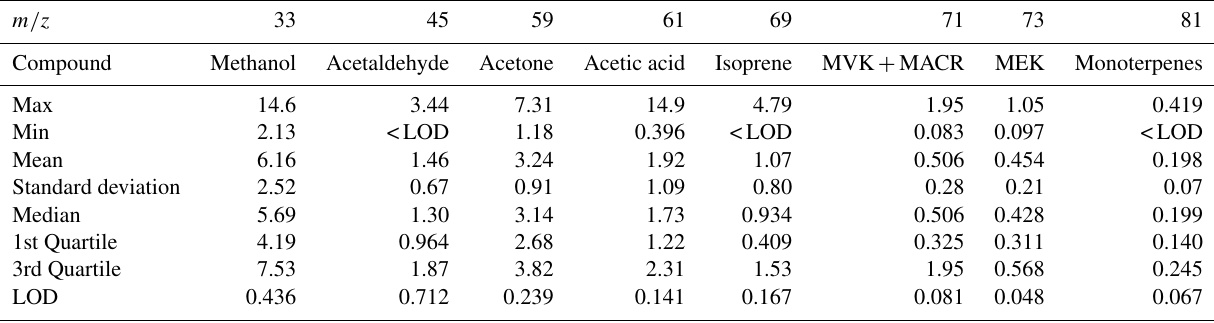
Table 2. Summary of the BVOC mixing ratios (ppbv) recorded at 4m above the forest canopy during the Bosco Fontana measurement campaign and limits of detection (LoD, ppbv), based on 25min averages.